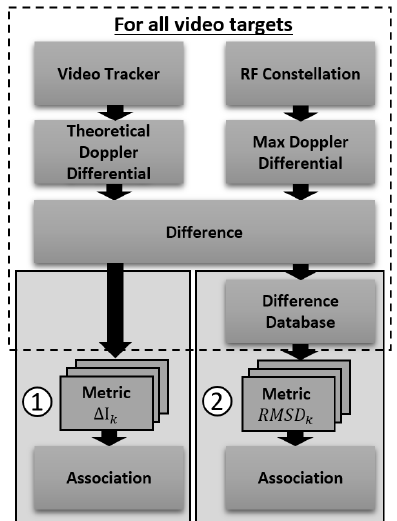
Figure 14. The process of associating the DD at a given frame measured from a constellation of RF sensors with the output of a multi-spectral video tracker using two statistical metrics; (1) absolute difference and (2) root-mean-square